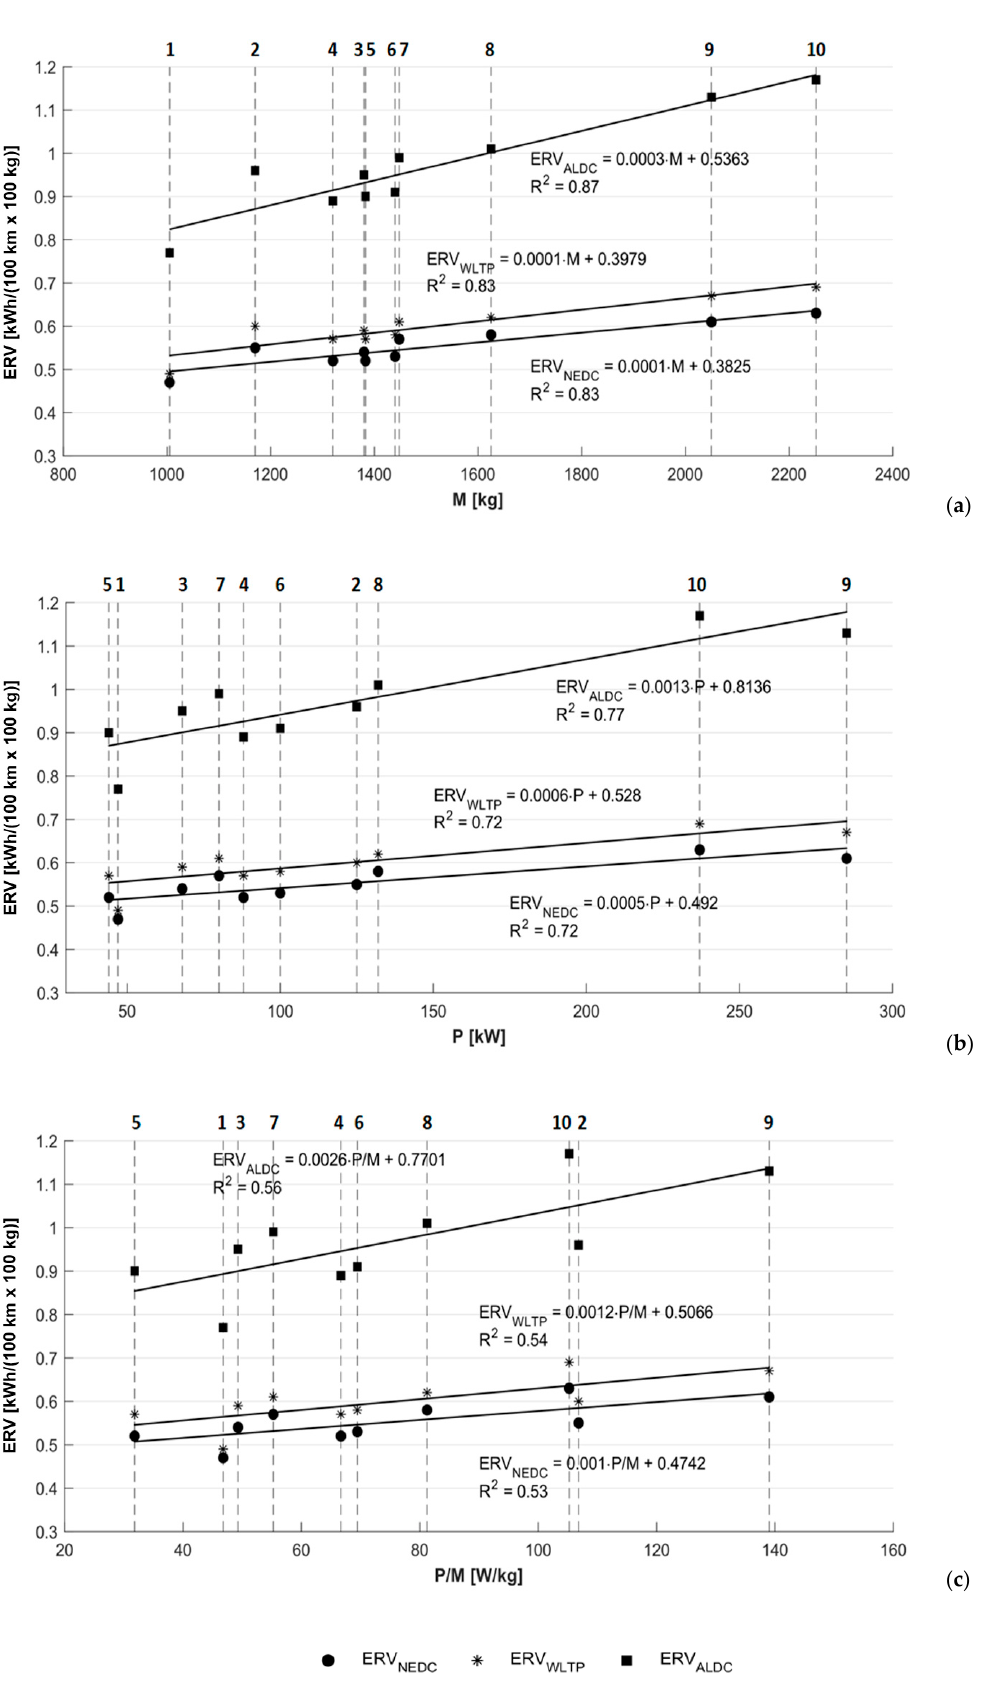
Figure 7. ERV for all case studies in function of main vehicle technical features: regression lines. Vehicle mass ( M ) ( a ), maximum power ( P max ) ( b ), and power-to-mass ratio ( P / M ) ( c